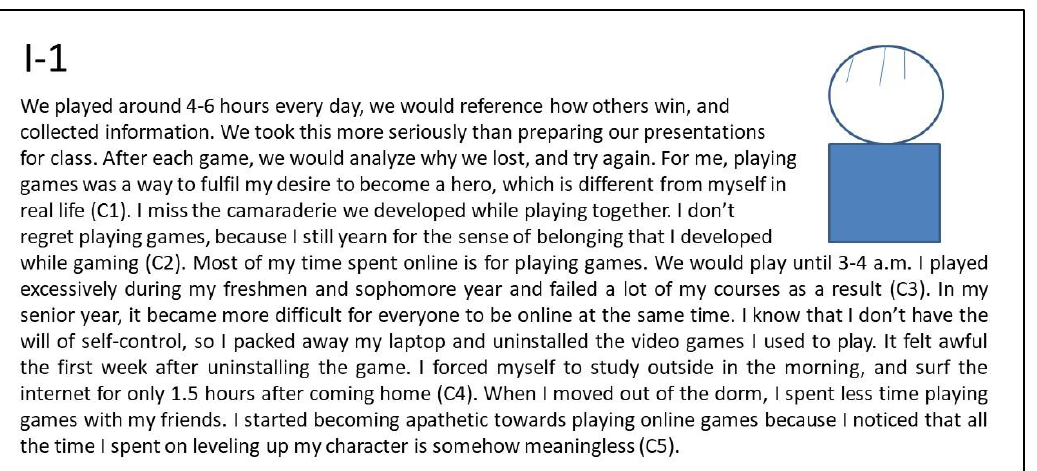
Figure 1. Person narrative about the first persona (I-1) .